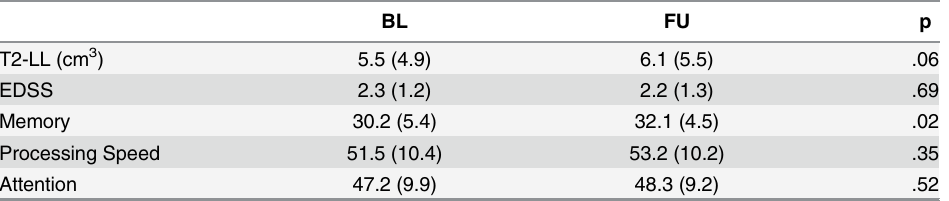
Table 2. Disease activity (T2-LL), motor and cognitive function at baseline (BL) and follow-up (FU) for patients with multiple sclerosis